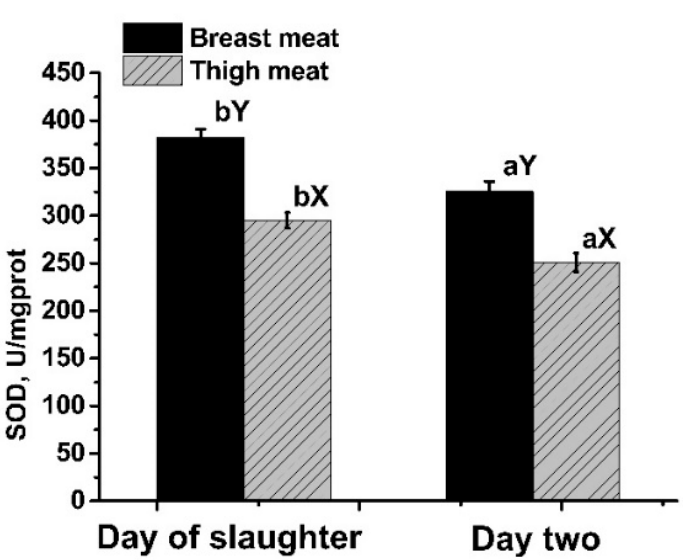
Figure 2. Effects of tissue and storage time on total-superoxide dismutase (T-SOD) activity. Means with no common superscripts between storage times (a, b) or tissues (X, Y) differ significantly (all p < 0.01).